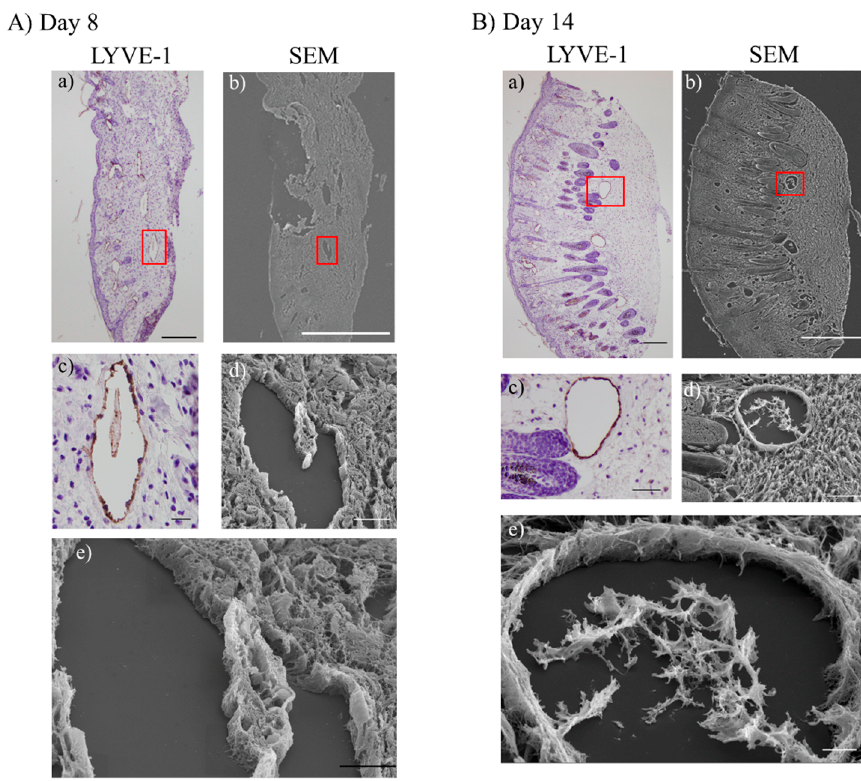
Figure 6. Observation of scanning electron microscopy (SEM) in the X-ray / ADSC ( +/+ ) groups. ( A , B ) Overlaid images of serial sections visualized by LYVE-1 immunohistochemistry and SEM observation. Rectangular shapes on (a) and (b) indicate position of high-magnification images (c–e). ( A ): Day 8, ( B ): Day 14. Scale bars (magnification); ( A -a) 200 µ m (40 × ), ( A -b) 500 µ m (37 × ), ( A -c) 20 µ m (400 × ), ( A -d) 20 µ m (900 × ), ( A -e) 10 µ m (2000 × ), ( B -a) 200 µ m (40 × ), ( B -b) 500 µ m (35 × ), ( B -c) 50 µ m (200 × ), ( B -d)